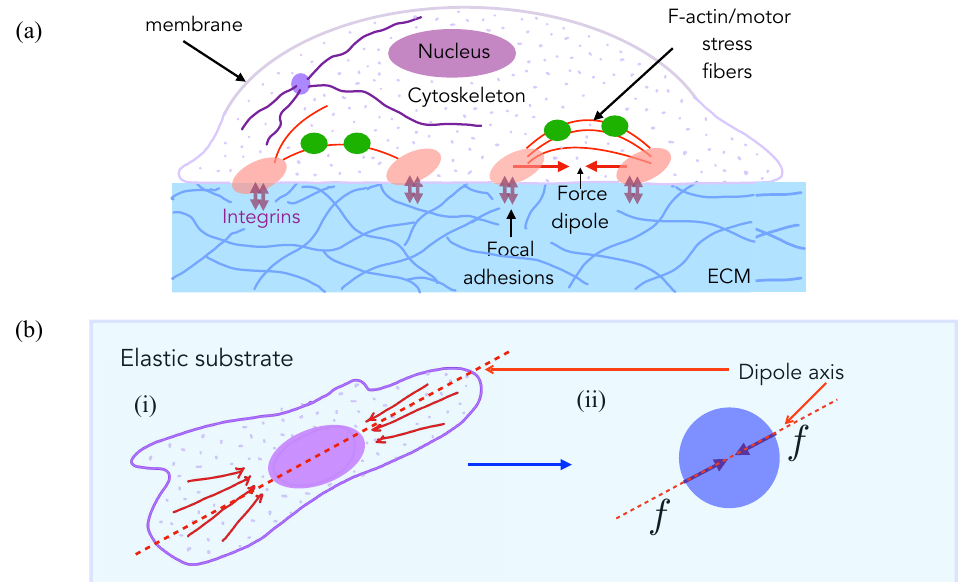
Figure 1. Traction forces that are exerted by motile cells on soft substrates can be modeled as force dipoles. ( a ) Schematic of an animal cell, e.g., an isolated fibroblast in culture [17] adhered to a compli- ant substrate through focal adhesions comprising of integrins and a host of other mechanosensitive adhesion proteins. Mechanical forces are actively generated by molecular motors of the myosin-II family that put the actin cytoskeleton under tension. Stress fibers are bundles of crosslinked actin filaments with a periodic (sarcomeric) organization of myosin [44] that often span the length of the cell and are anchored at the focal adhesions to the extracellular substrate or matrix (ECM). The contractile forces are transmitted at these sites from the stress fibers to the underlying substrate, which can be strongly deformed if soft. Such deformations are long range (they extend up to a few cell lengths away from the cell) and they can be measured by Traction Force Microscopy (TMF). This is a common index of cell–substrate mechanical interactions. ( b ) (i) A simplified top view of the same cell showing the alignment of the stress fibers and, therefore, of the contractile forces that are generated by them. In order to model the effects of the cell on the substrate, we use classical linear elasticity theory with the stress distributions effectively modeled as a contractile force dipole, a pair of equal and opposite forces separated by some distance acting along the dipole axis (marked). (ii) This leads to a very simplified mechanical model of the cell in terms as a contractile force dipole that is exerted on the substrate along its average axis of orientation defined by the alignment of its stress